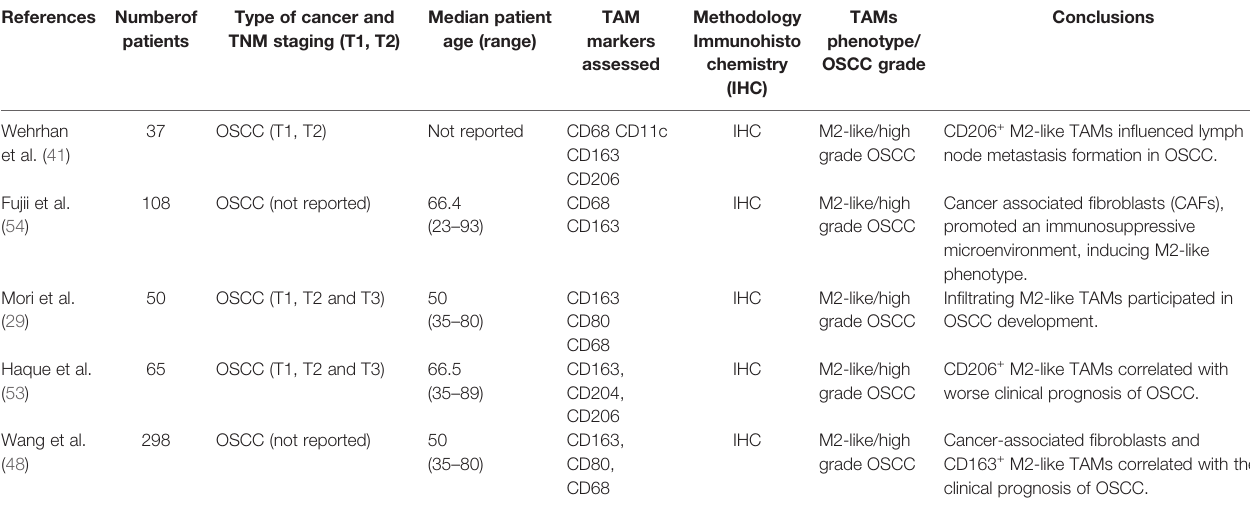
TABLE 1 | Main human studies of TAMs in